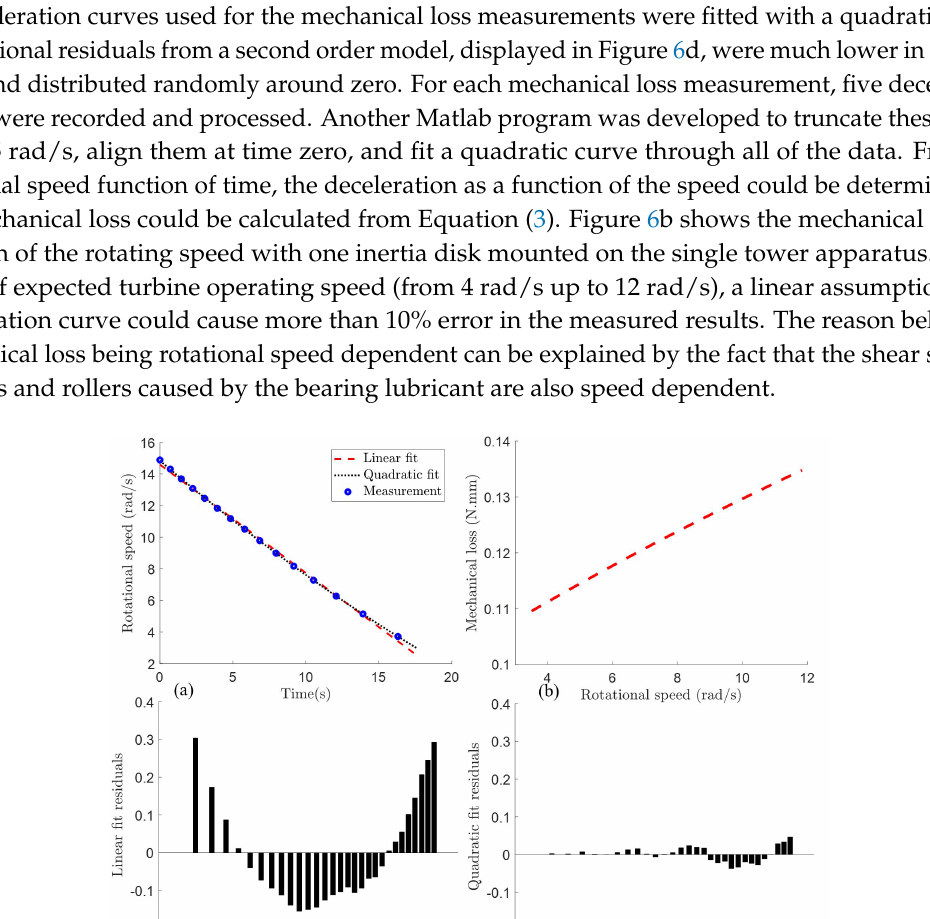
Table-top experiments of turbine power measurement often face with the problem of the system mechanical loss being comparable to the turbine hydrodynamic torque and cannot be neglected.